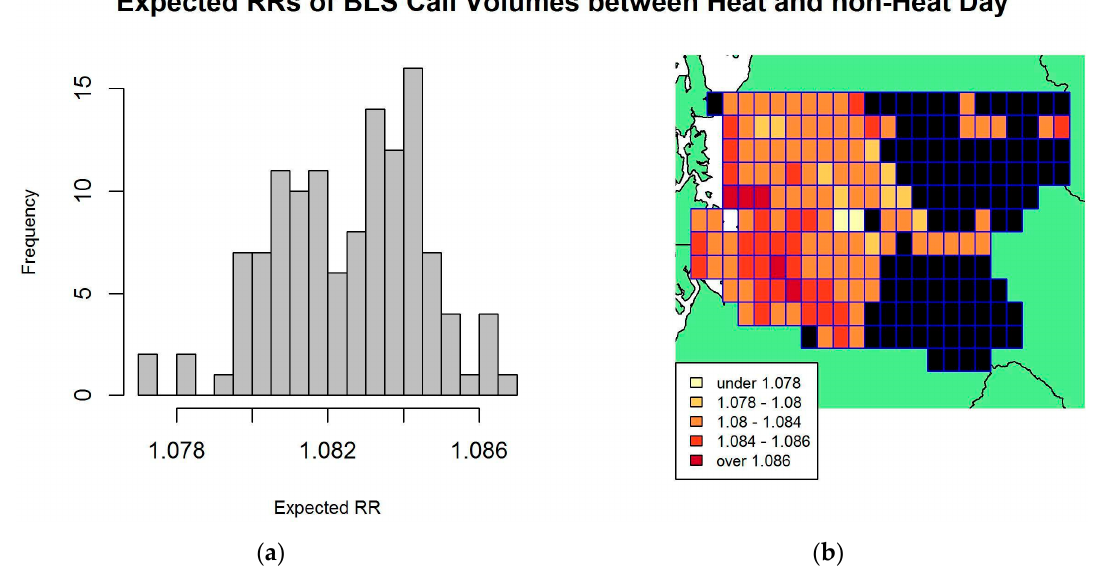
Figure 3. Relative rate (RR) analysis on BLS data: ( a ) Histogram of expected RRs of BLS call volumes between heat and non-heat day, defined by humidex threshold of 31.1 °C; ( b ) King County, Washington’s Grid map of expected RRs for BLS data, where black indicates grid cells without call data or too few call data to be included in the analysis. Each grid cell has size of 4 km by 7.5 km.